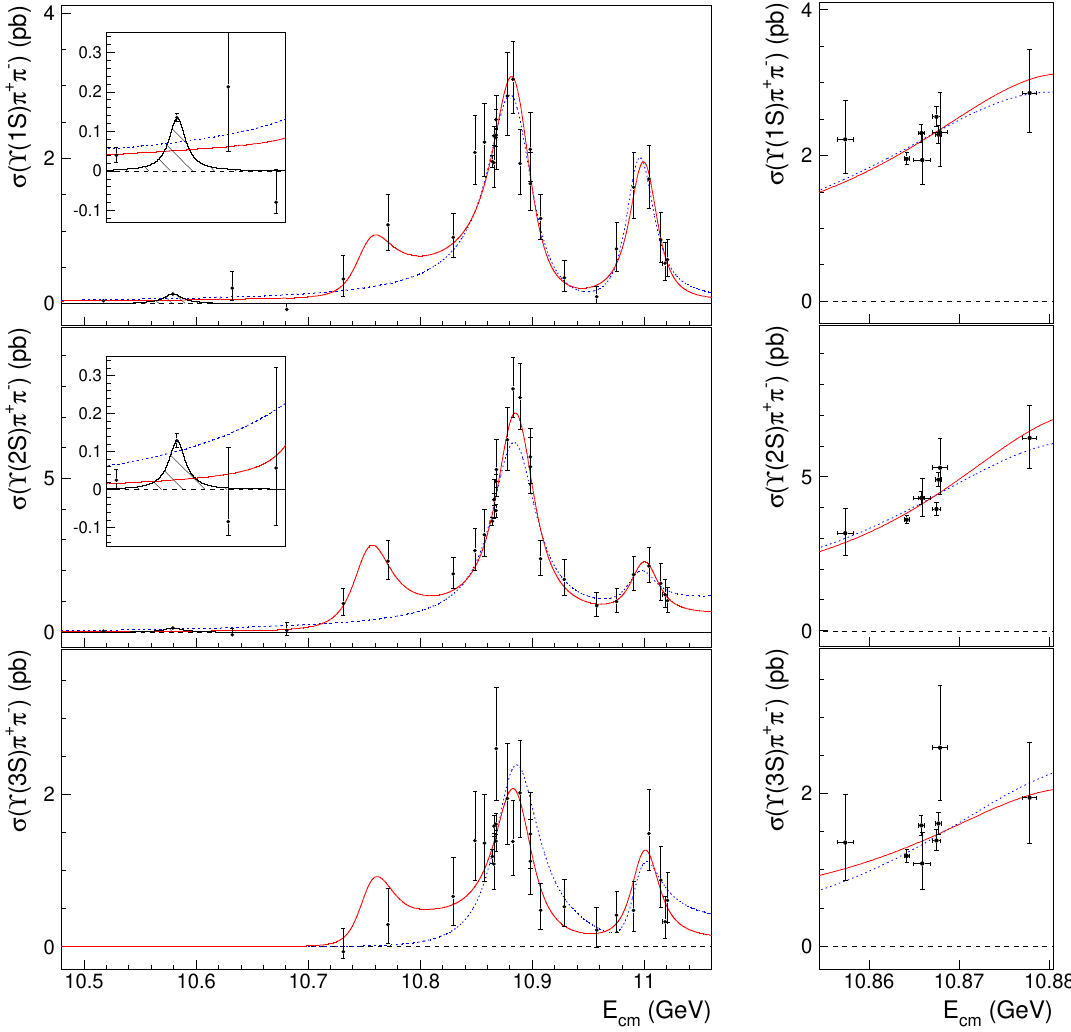
Figure 10 . Energy dependence of the e + e (cid:0) ! (cid:7)( nS ) (cid:25) + (cid:25) (cid:0) cross sections ( n = 1 ; 2 ; 3 from top to bottom). The points with error bars are data with combined statistical and uncorrelated systematic uncertainties; the curves are the results of the simultaneous (cid:12)t to these distributions and the M recoil ( (cid:25) + (cid:25) (cid:0) ) distribution in the on-resonance data ((cid:12)gure 11). Shown are the results of the default (cid:12)t (red solid curve) and the (cid:12)t with the new structure excluded in all channels (blue dotted curve). The hatched histograms and the points with error bars at their maxima show the (cid:7)(4 S ) line shapes and the cross sections measured at the (cid:7)(4 S ) peak in ref. [34]. These points are not used in the (cid:12)t to the cross section energy dependence. Insets show a zoom of the low energy region, while right side panels show a zoom of the (cid:7)(10860) on-resonance region. The (cid:12)t results are presented in (cid:12)gures 10 and 11. For illustration, we show in (cid:12)gure 10 the cross sections measured at the (cid:7)(4 S ) peak and the expected (cid:7)(4 S ) line shape; these measurements are not used in the (cid:12)t. The (cid:12)t results for masses and widths of the (cid:7)(10860), (cid:7)(11020), and new structure are presented in table 3. The results are slightly shifted from the previous Belle measurements based on the same data sample [11] because we